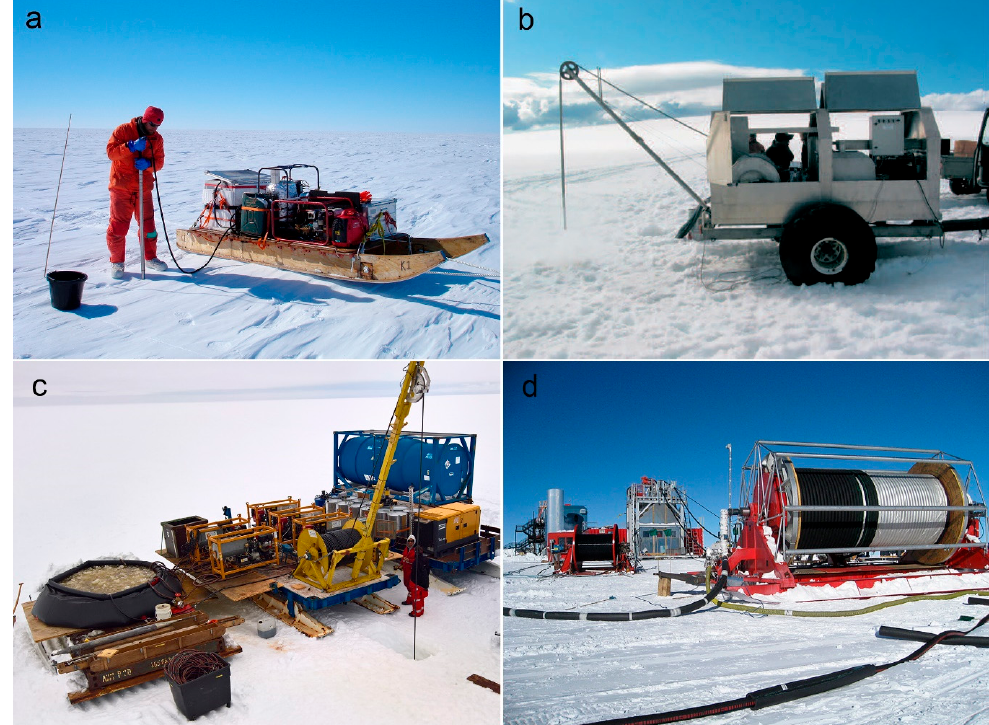
Figure 1. Examples of hot-water drilling systems: ( a ) BAS (British Antarctic Survey) lightweight hot-water drill for seismic survey, Pine Island Glacier, Antarctica, season 2006–2007 (Photo from personal communication: R. Stilwell, British Antarctic Survey); ( b ) shallow drilling with hot-water drilling system of Hydrological Service Division of the National Energy Authority, Iceland on the Langjökull ice cap, 2005 [5]; ( c ) overview of intermediate-deep AWI hot-water drill, Ekström ice shelf, Antarctica, January 2018; ( d ) hose reel and tower of IceCube deep hot-water drilling system, December 2008 (Photo from personal communication: J. Haugen from IceCube, 2008).